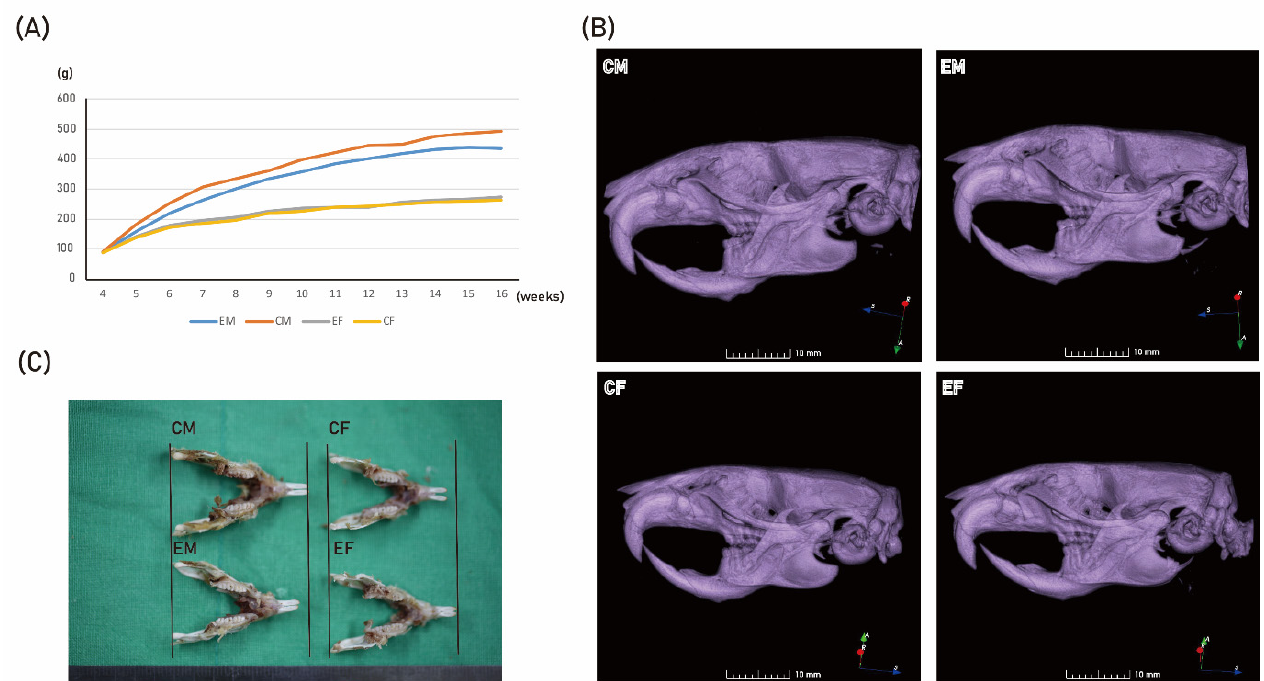
Figure 2. Animal study results. The administration of 4HR decreased body-weight and mandibular size in the EM group, but increased mandibular size in the EF group. ( A ) Body-weight changes in each group. Compared to the control male (CM) group, the experimental male (EM) group showed smaller body weight. However, it was almost the same between the control female (CF) and experimental female (EF) groups at all observation points. ( B ) Three-dimensional reconstructed images of micro-computerized tomogram. EM group had a smaller facial skeleton compared to that of the CM group. The CF group, on the other hand, had a smaller facial skeleton than that of the EF group. ( C ). When the mandibular size was compared among groups, mandibles from the CM group were larger than those from the EM group. However, females showed the opposite trend. Table 1. mCT measurements. The mandibular size was generally smaller in the EM group compared to that in the CM group. However, the measurements for the mandibular size were larger in the EF group compared to in the CF group. The unit for each measurement was mm.